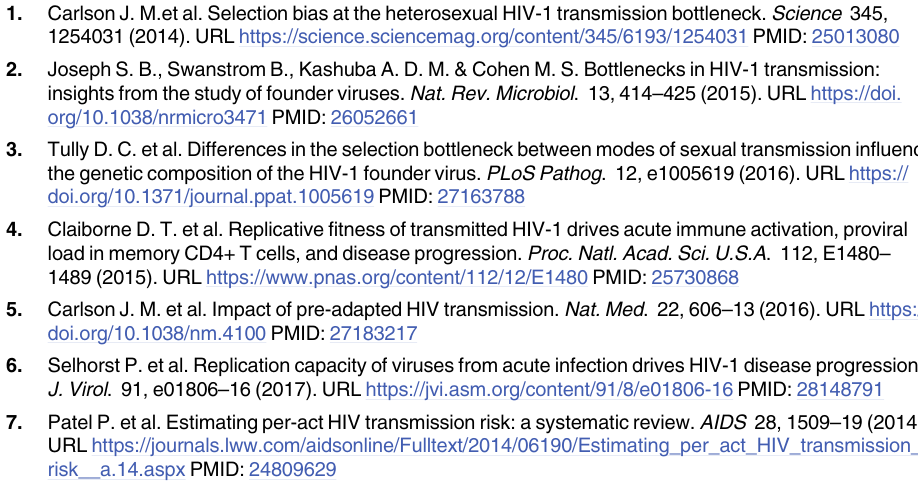
S8 Table. Association of MSM and HET with transmission clusters. The percentages of indi- viduals found to be associated with transmission clusters in MSM and HET in several studies are collated. In the second column, the numbers in parantheses indicate sample sizes exam- ined. Where available, P values and the largest cluster sizes are indicated as other